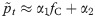
Search of CC and MCC patterns in the repeated PDG on the square lattice.(A) Schematic of the linear fit, p˜t≈α1fC+α2. (B) Slope α1 of the linear fit when not conditioned on the focal player’s previous action, at−1. (C) α1 when conditioned on at−1 = C. (D) α1 when conditioned on at−1 = D. (E) Difference between the intercept, α2, obtained from the linear fit conditioned on at−1 = C and that conditioned on at−1 = D. For each combination of the β and A values, a linear fit was obtained by the least-squares method on the basis of the 102 players, tmax = 25 rounds, and 103 simulations, yielding 2.5 × 106 samples in total.